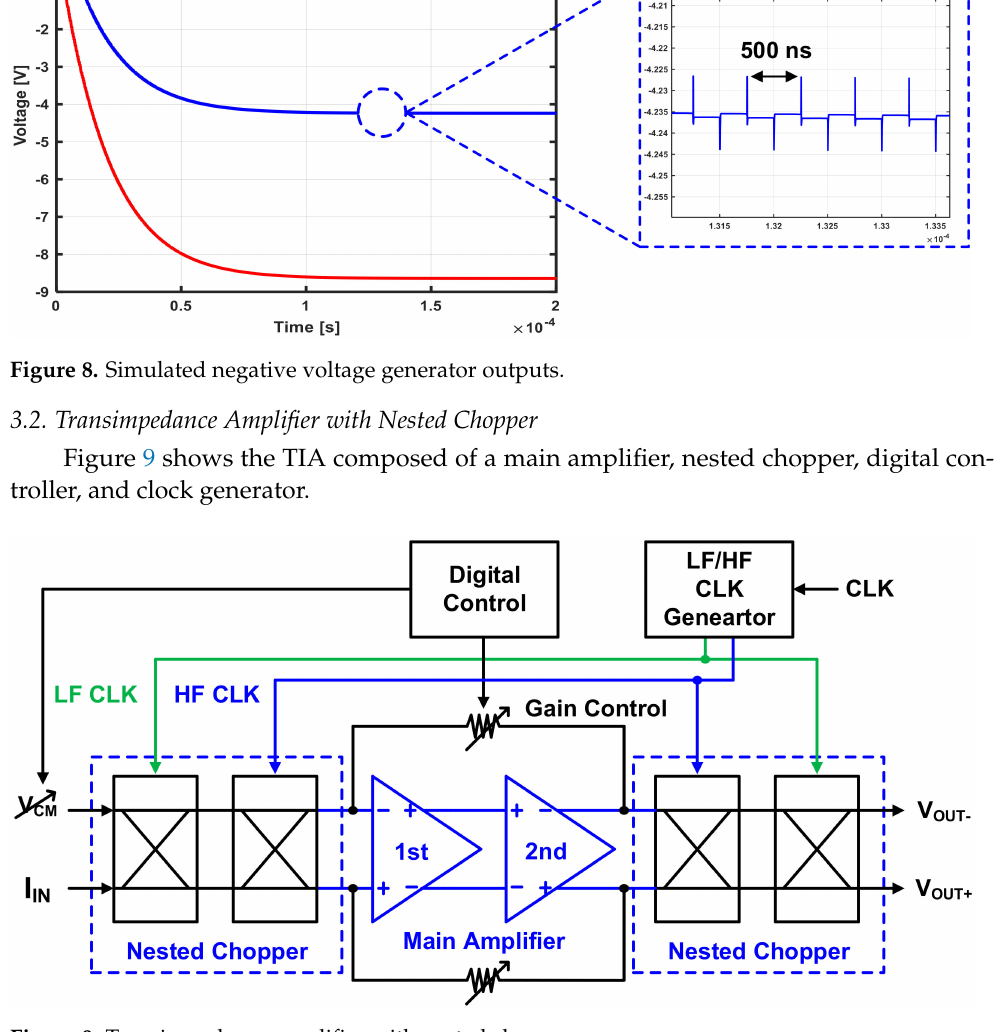
Figure 9. Transimpedance amplifier with nested